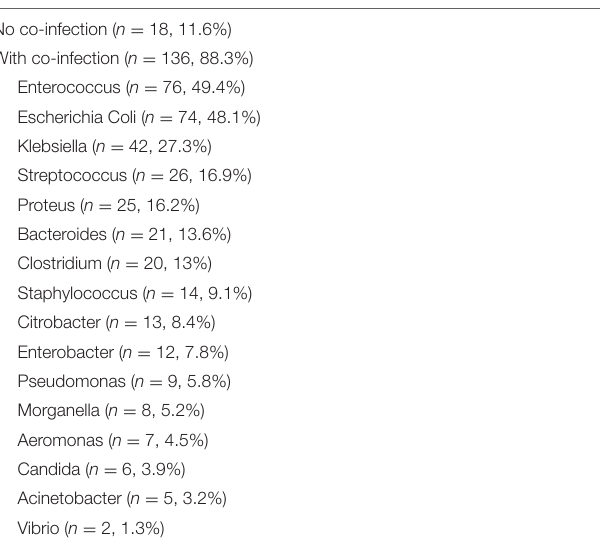
TABLE 2 | Common organisms involved in co-infection with Shewanella (specimen n = 154). No co-infection ( n = 18, 11.6%) With co-infection ( n = 136, 88.3%)